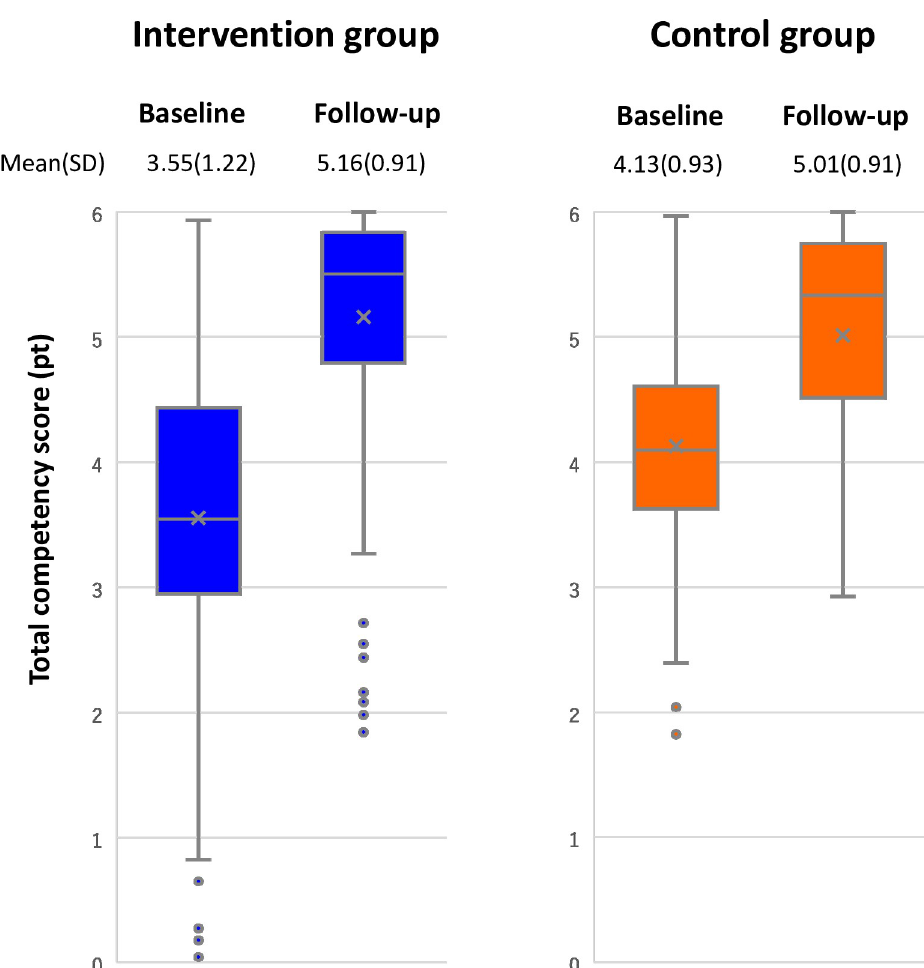
Fig 3. Comparison of mean and standard deviation of total competency scores between groups.